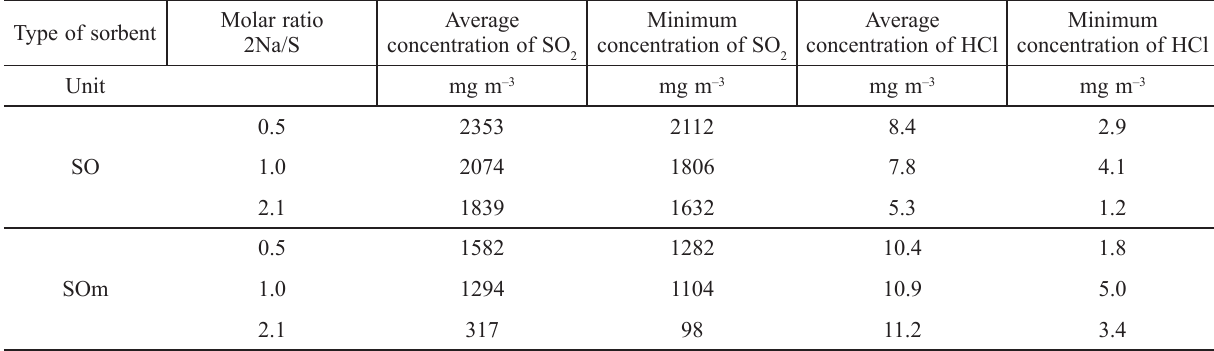
Table 4 – Values of the average and the minimum concentration of SO and HCl in the flue gas after the application of sodium 2 compounds Molar ratio Average Minimum Average Minimum Type of sorbent 2Na/S concentration of SO concentration of SO concentration of HCl concentration of HCl 2 2 Unit mg m –3 mg m –3 mg m –3 mg m –3 0.5 SO